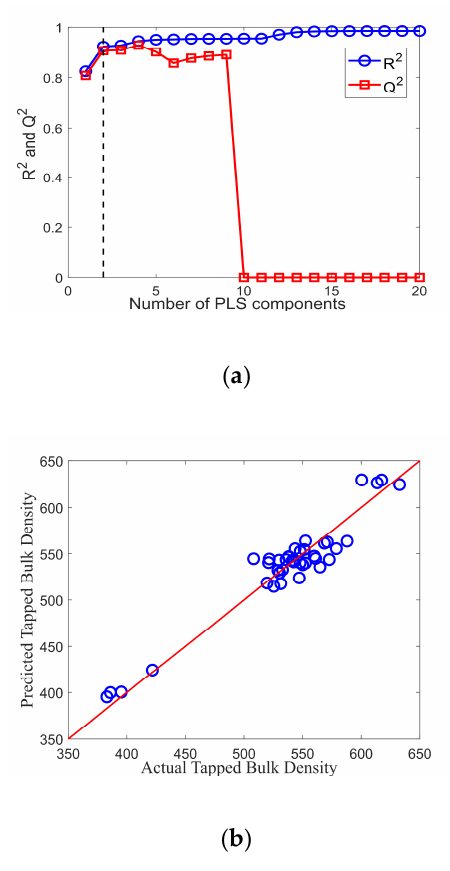
Figure 13. ( a ) R2 and Q2 versus the number of PLS components for the PLS model of tapped bulk density; ( b ) Predicted tapped bulk density versus actual tapped bulk density of IWMP samples.